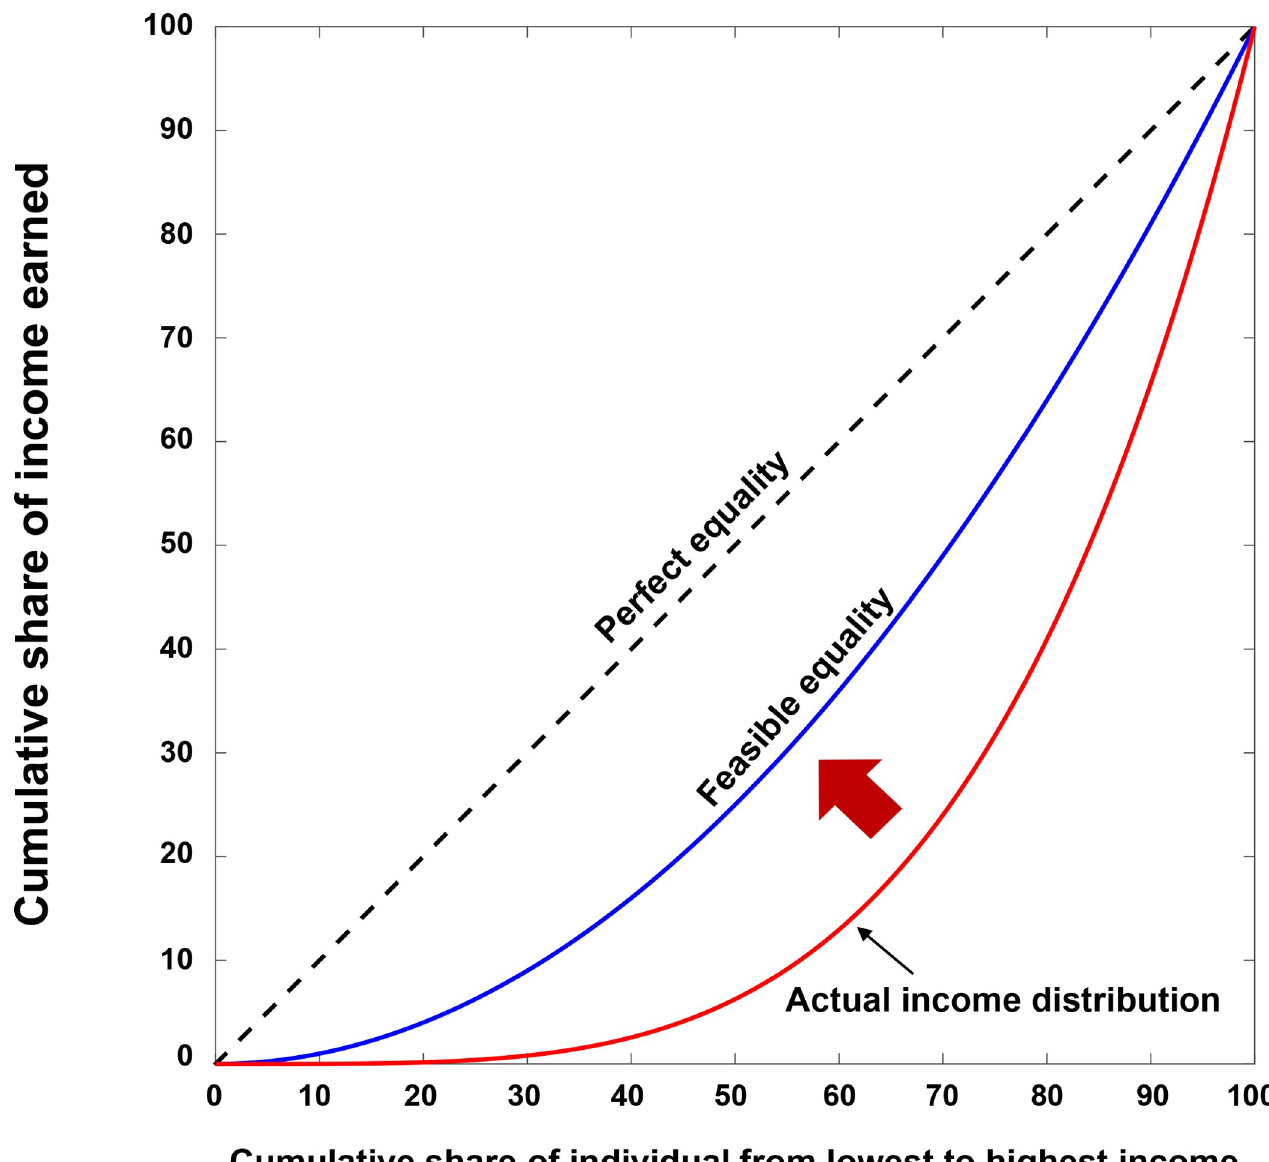
Fig 1. The Lorenz curve of a typical country. The hypothetical feasible equality line (blue) can serve as a practical guideline for government policies and interventions (red arrow).